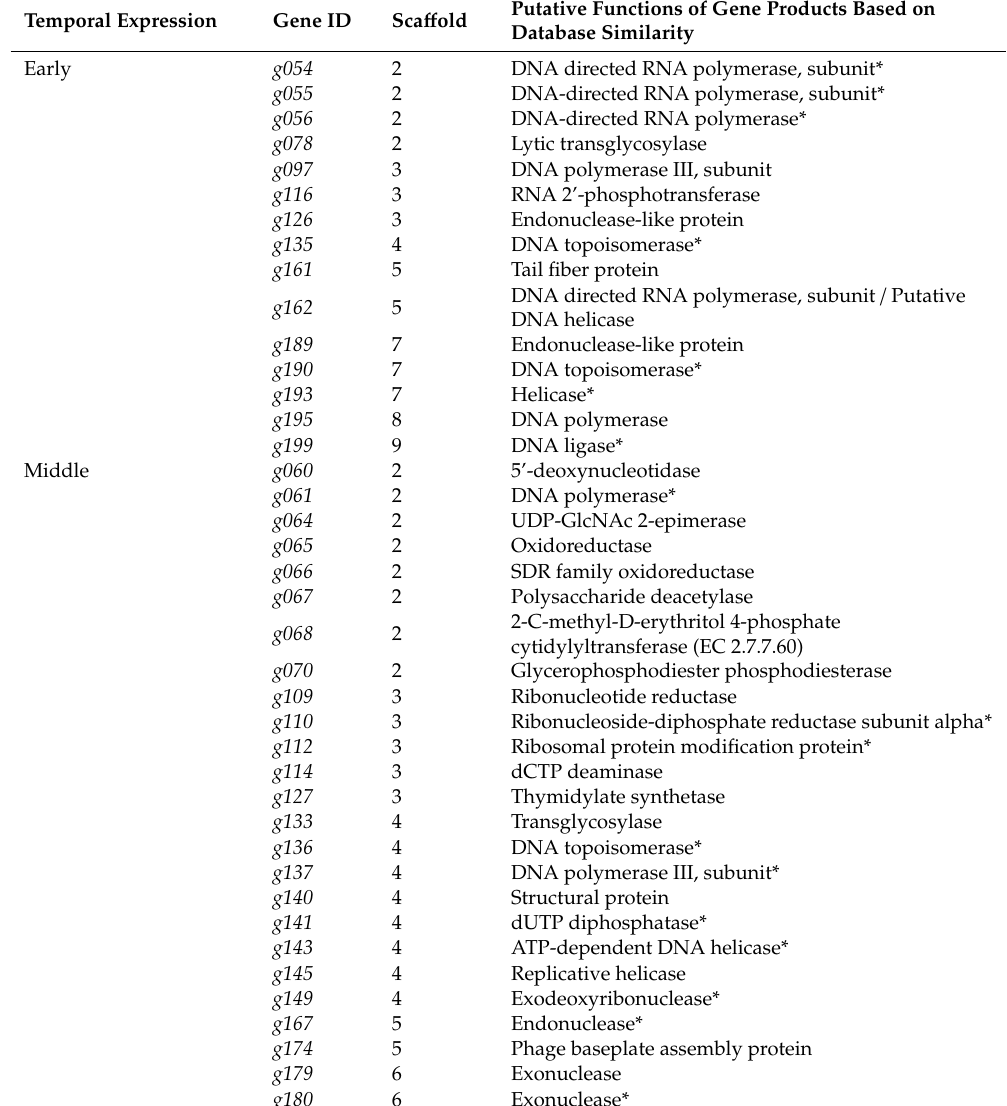
Table 3. Temporal expression profiles of the gene products of phage YerA41 having predicted functions. The full list of all gene products, including the hypothetical proteins of unknown function, is presented in Supplementary Table S2. The LC-MS / MS-identified PPAPs are marked with